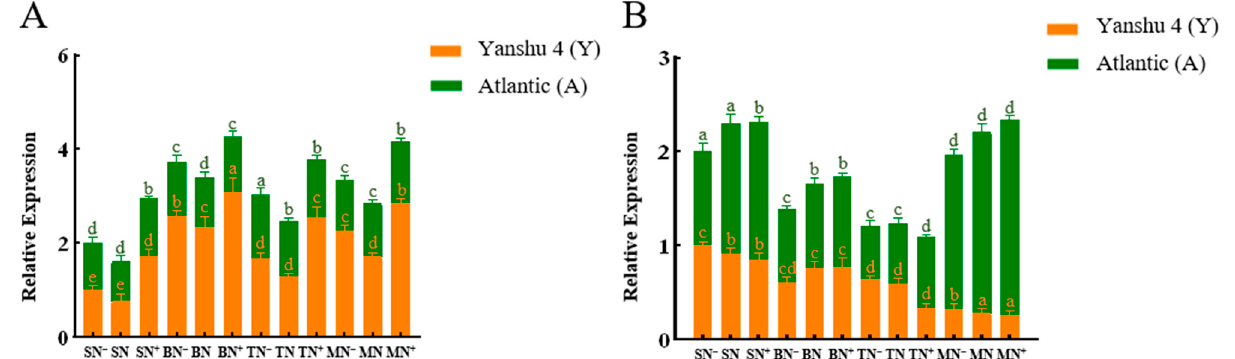
Figure 8. Relative expression of glutamate synthase gene StFd-GOGAT in two genotypes of potato under different N supply levels. ( A ) Leaf (L); ( B ) Root (R). S, B, T, and M represent seedling stage, budding stage, tuber expansion stage, and mature stage, respectively. N − , N, N + are different N supply levels, representing low N, normal N, and excess N, respectively. Different letters indicate the difference of relative gene expression in different periods under different N application levels ( p < 0.05).